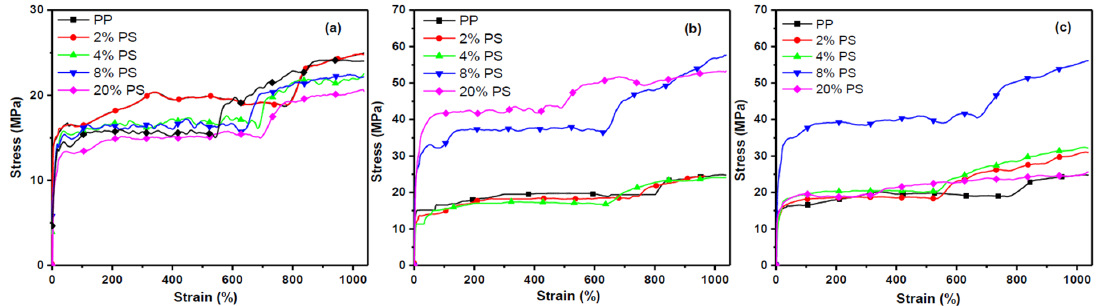
Figure 8. The stress-strain curve of PP and PS/PP blend fibers, ( a ) PS1/PP; ( b ) PS2/PP; ( c ) PS3/PP.